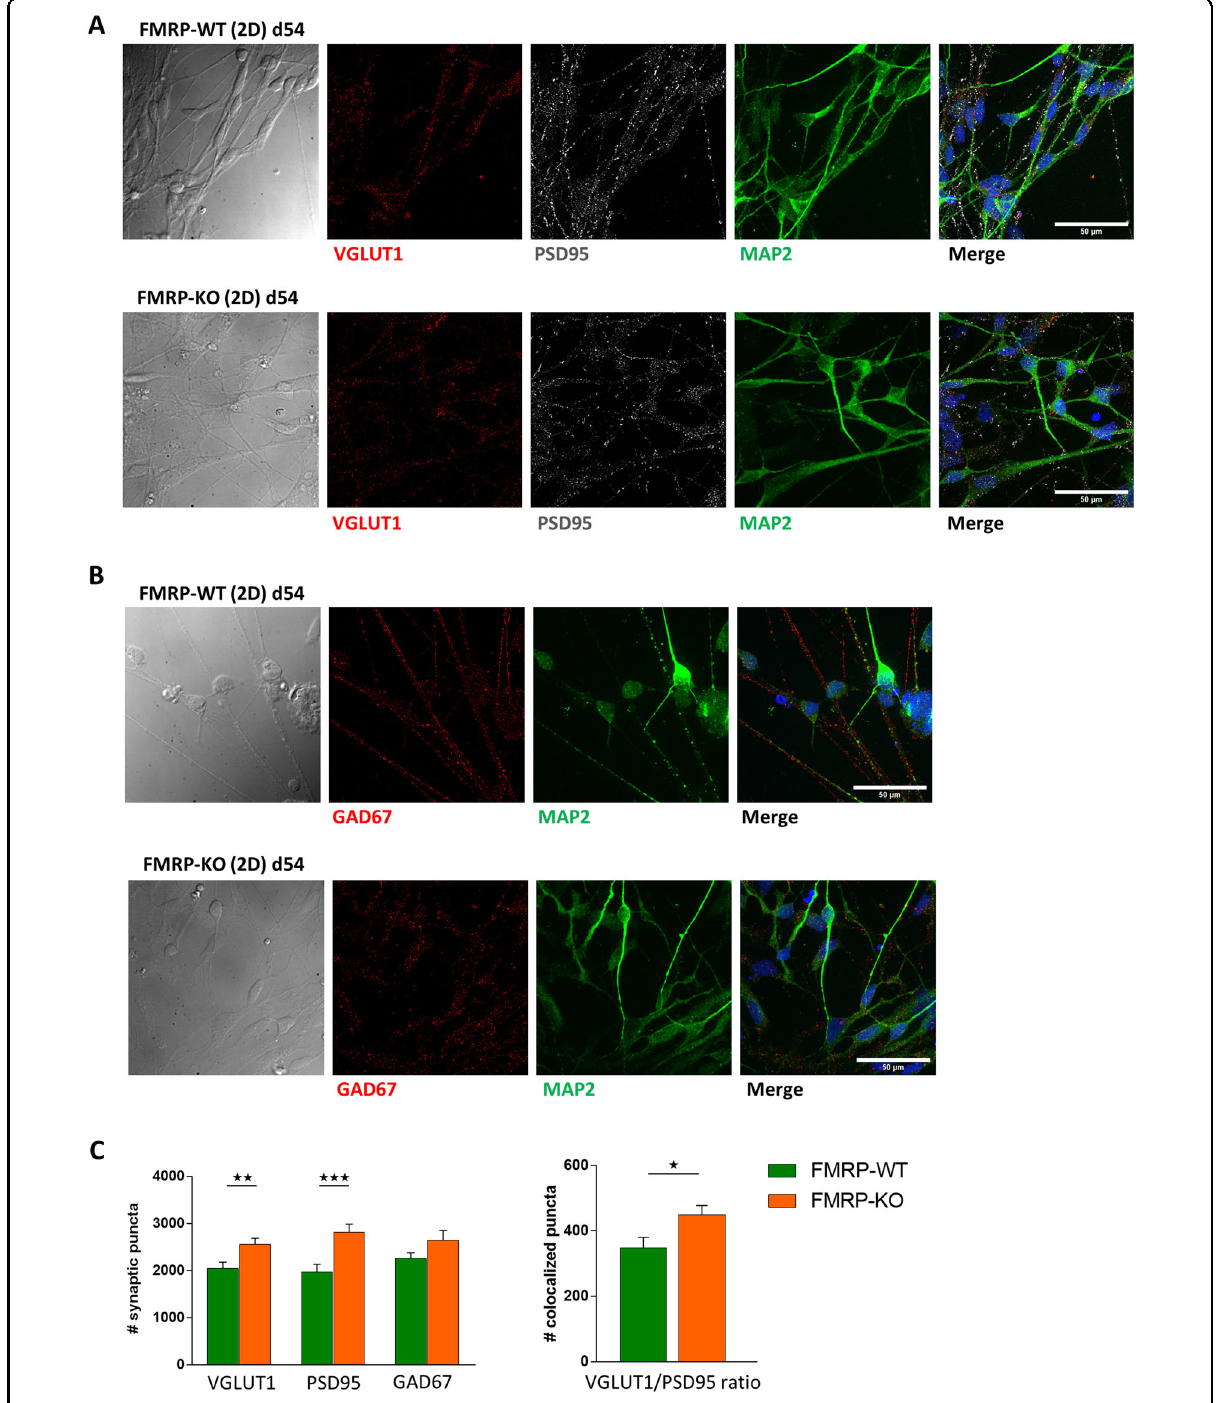
Fig. 3 Immuno fl uorescence analysis of 2D cortical cultures at day 54. A Representative immuno fl uorescence and transmitted images of glutamatergic synapses at day 54 in 2D cortical cultures differentiated from FMRP-WT (top) and FMRP-KO (bottom) hiPSCs. Glutamatergic synaptic puncta are identi fi ed as positive for VGLUT1 (pre-synaptic, red) and PSD95 (post-synaptic, white), respectively. Nuclei were stained with DAPI (blue) and dendrites with MAP2 (green). Scale bar: 50 µm. B Representative immuno fl uorescence and transmitted images of GABAergic synapses at day 54 in 2D cortical cultures differentiated from FMRP-WT (top) and FMRP-KO (bottom) hiPSCs. GABAergic pre-synaptic puncta are shown as positive for GAD67 (red). C Bar charts representing (left) the quanti fi cation of glutamatergic and GABAergic synaptic puncta (VGLUT1 puncta WT 2050 ± 130, KO 2550 ± 140, ** p < 0.01; PSD95 puncta WT 1980 ± 160, KO 2810 ± 180, *** p < 0.001 MW test; GAD67 puncta WT 2250 ± 130, KO 2640 ± 210, p = 0.11; n = 30/2 FOVs/differentiation batches for each genotype) and (right) VGLUT1/PSD95 colocalization ratio in both genotypes (VGLUT1/PSD95 colocalized puncta WT 350 ± 30, KO 450 ± 30, * p < 0.05 MW test; n = 30/2 FOVs/; differentiation batches for each